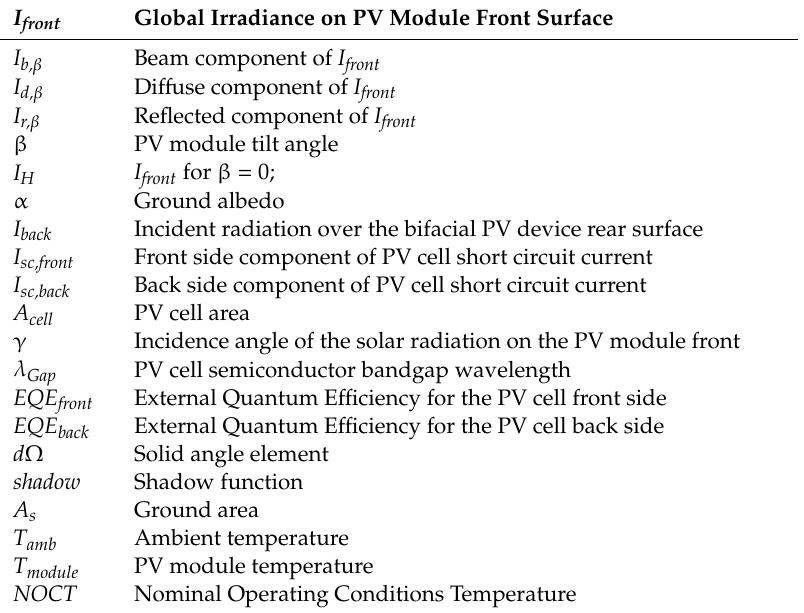
Table 1. Definitions of the symbols used in Equations